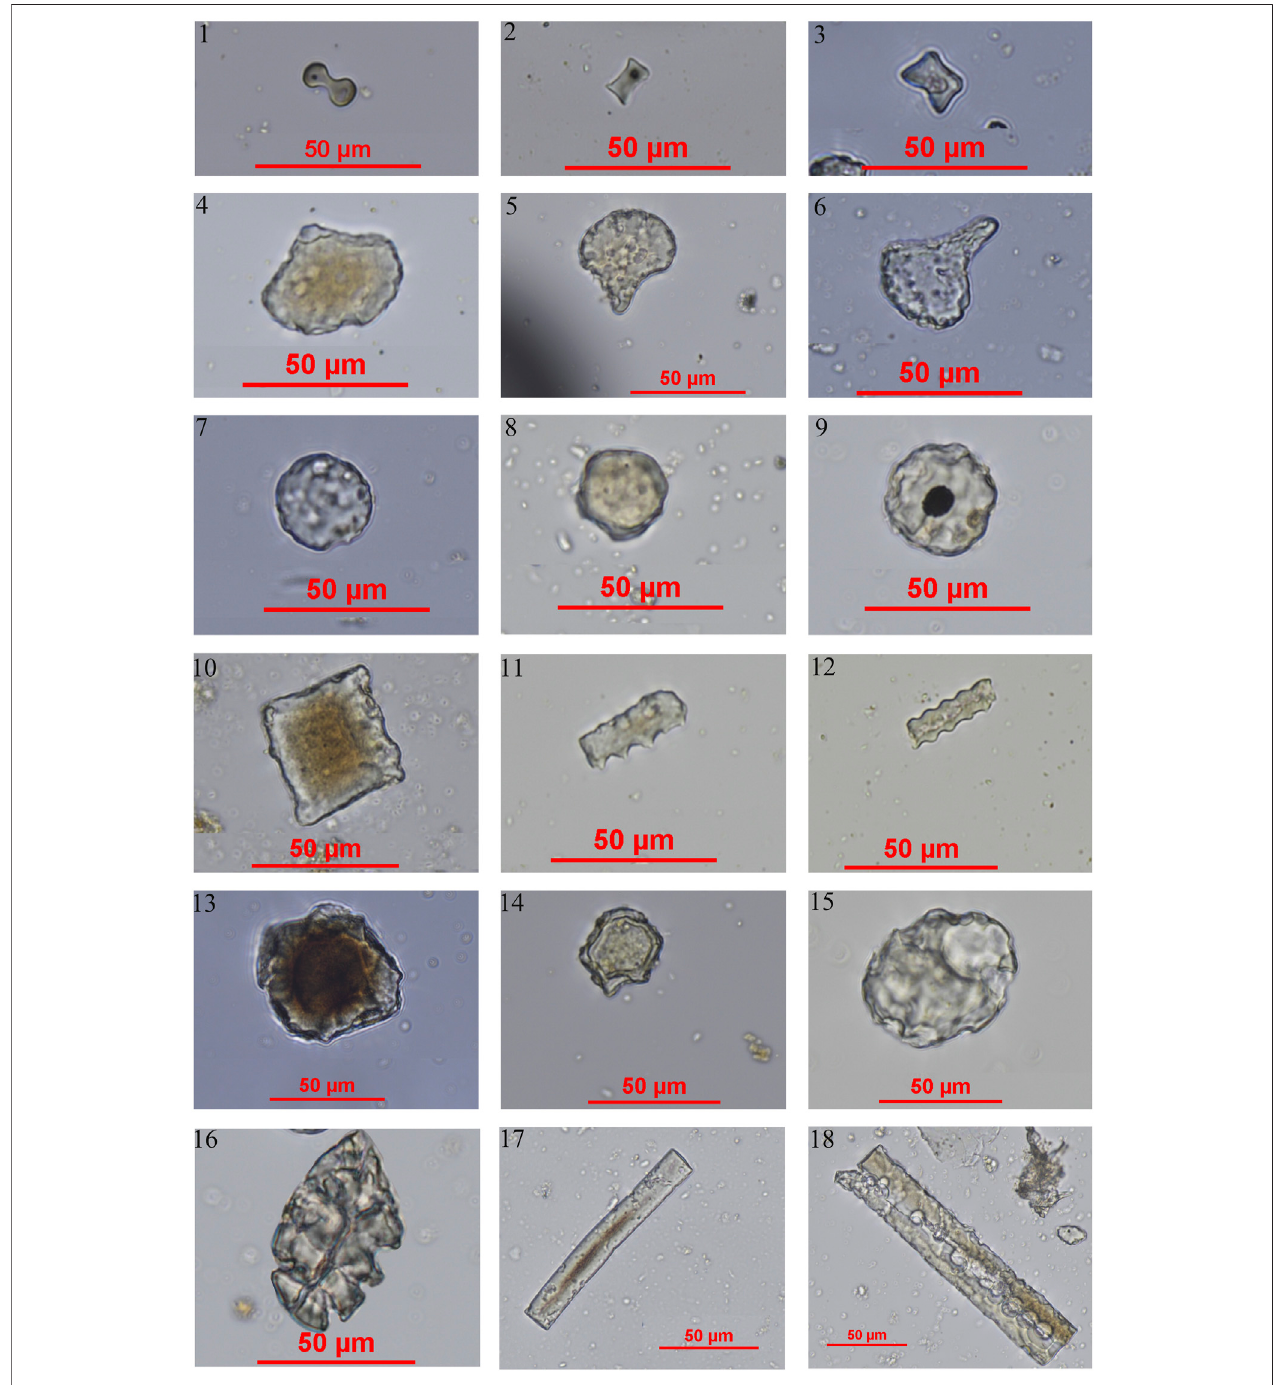
FIGURE 7 | Phytoliths recovered from Dingsishan plant residues. 1. Bilobate 2 – 3. Short cell (Two-spiked rondels) 4 – 6. Bulliform cells 7 – 9. Globular echinate 10. Rectangle 11. Elongate echinate; 12. Elongate sinuate 13 – 16. Polyhedron from wood 17. Smooth elongate 18. Elongate from wood.